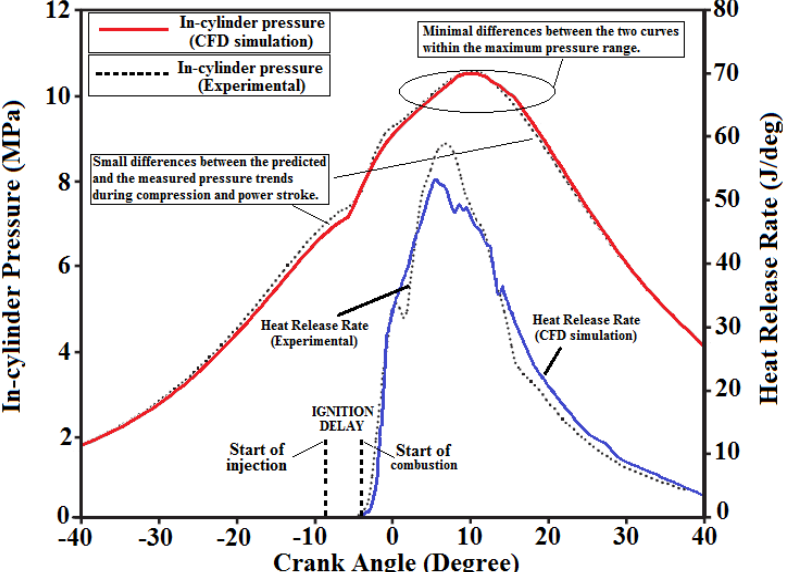
Figure 4. Comparison between predicted and measured in-cylinder pressure and